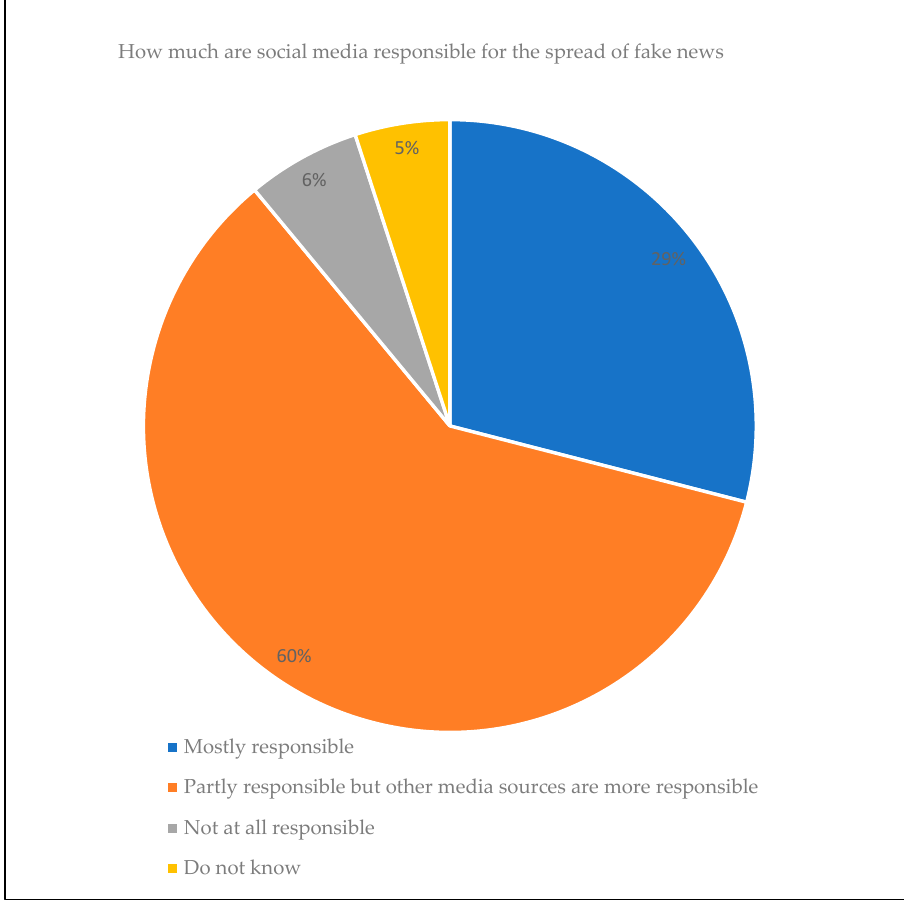
Figure 3. Social media’s role in spreading fake news (Available from: https://www.statista.com/statistics/649221/fake-news-expose-responsible-usa, accessed on 4 March 2021).